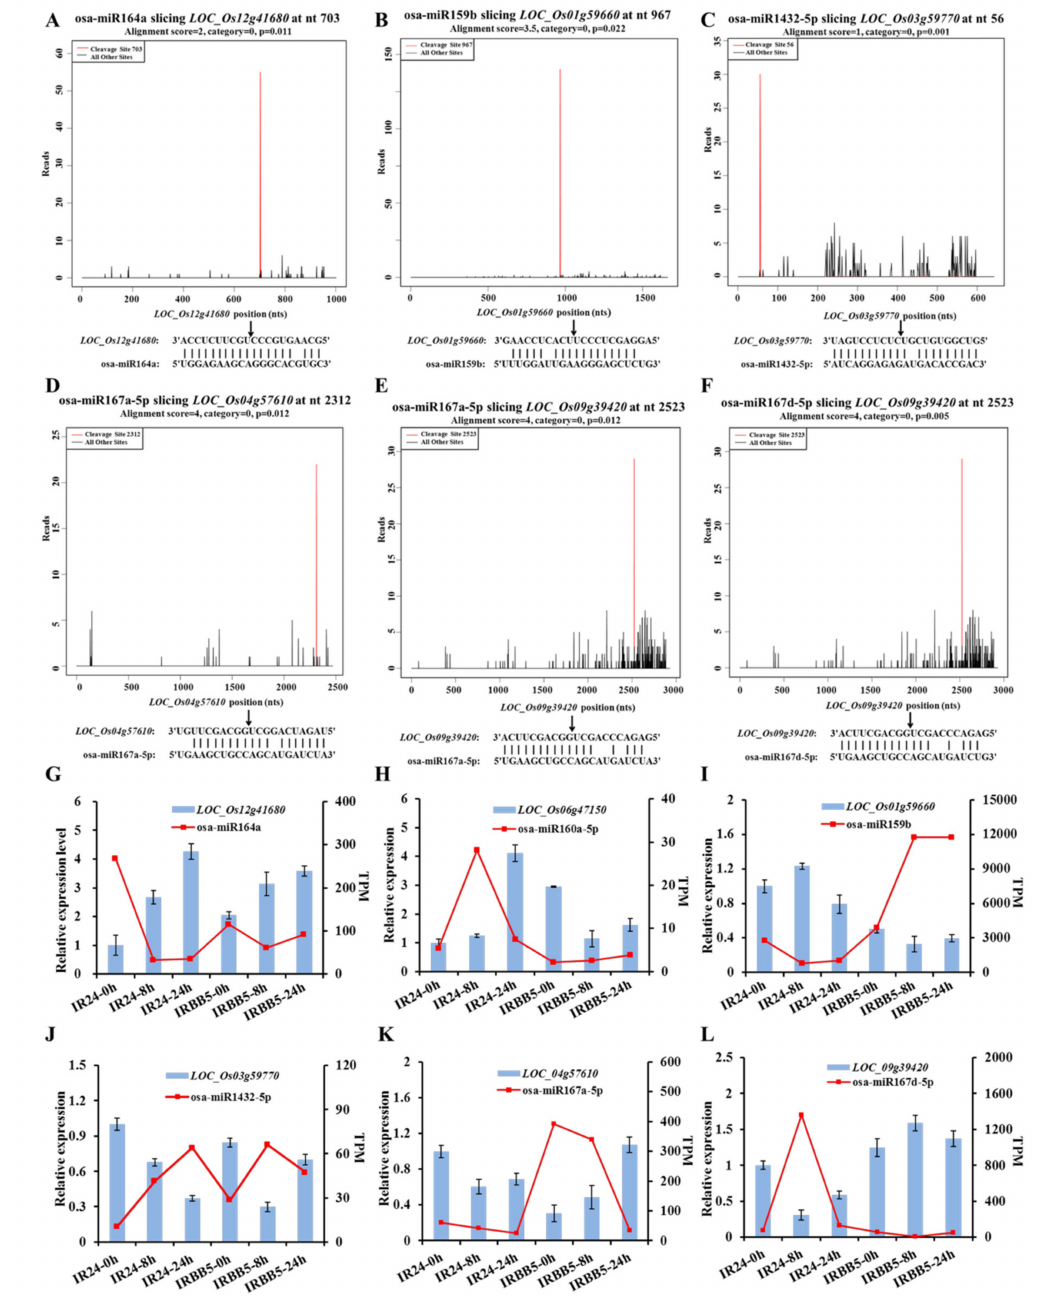
Figure 6. The negative correlation identification of miRNA and target genes. ( A – F ) Target plots (T-plots) of representative miRNA targets validated by degradome sequencing. The red lines showed the distribution of the degradome tags along the target mRNA sequences. The black arrows represented the cleavage sites of miRNAs on the target genes. ( G – L ) The relative expression levels of miRNA and targets at di ff erent time points in Xoo -infected IRBB5 and IR24. The histogram and red dot indicate the expression levels of targets from quantitative reverse transcriptase-polymerase chain reaction (qRT-PCR) analysis and miRNA sequencing data,